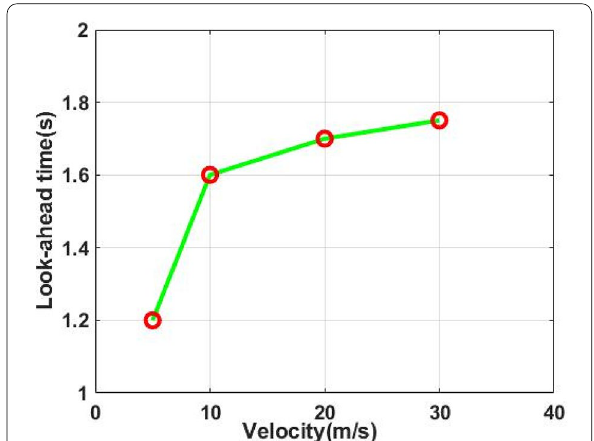
Figure 2 Mapping between the velocity and look-ahead